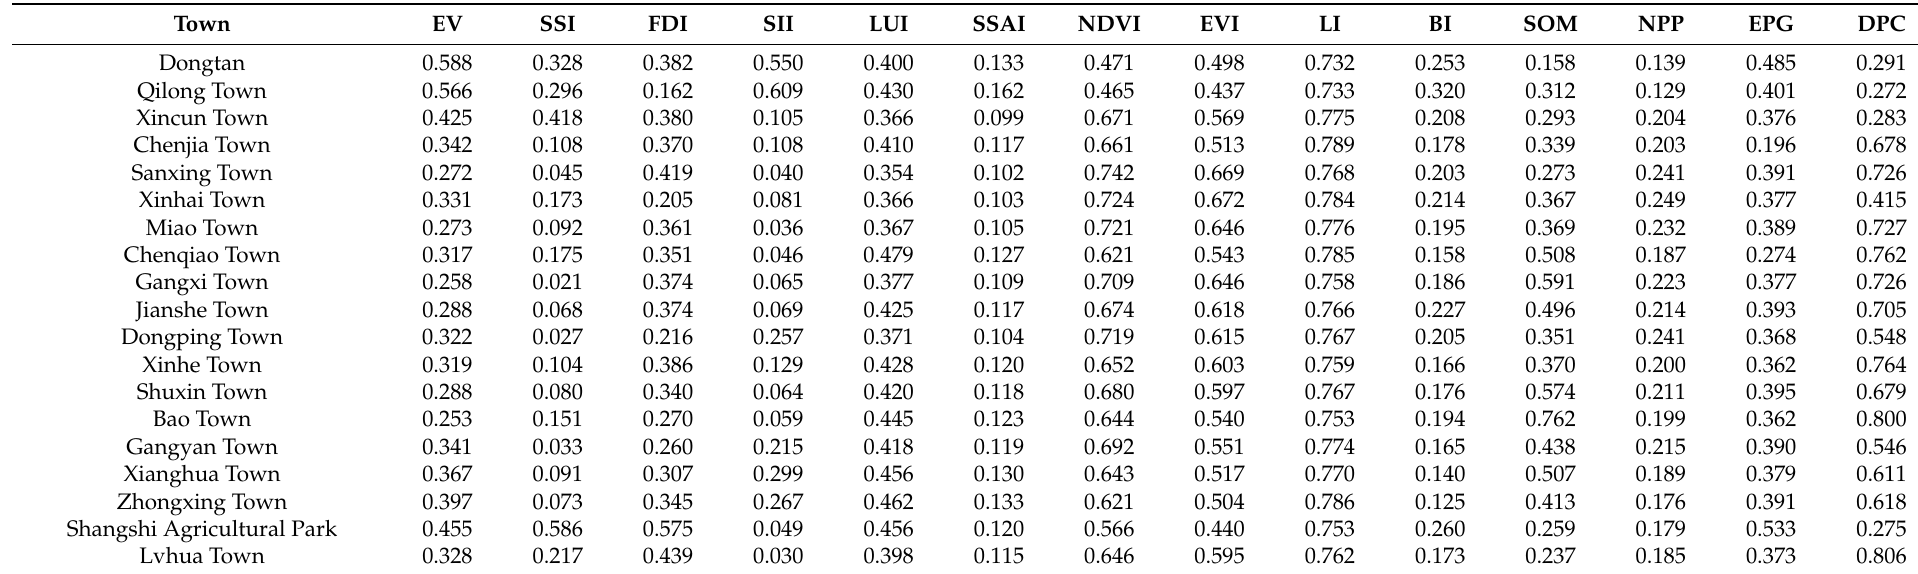
Table A5. The ecological vulnerability of each town in